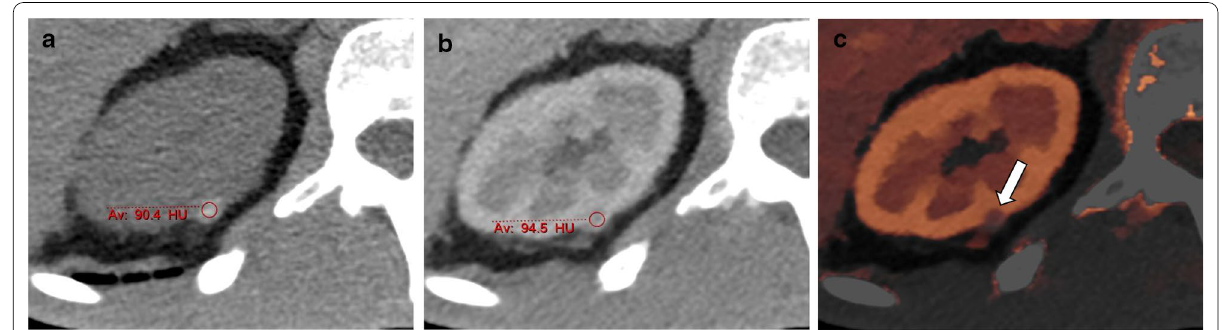
Fig. 4 An incidentally identified hyperdense right renal cyst in a 72-year-old man. Axial TNC image shows a markedly hyperdense cyst, most consistent with a hemorrhagic cyst ( a ) without enhancement on the portovenous phase image ( b ). However, iodine overlay maps show suspected mild enhancement ( c ). The iodine content of the cyst was 1.3 mg/mL, which by accepted thresholds would be considered an enhancing lesion, however, the normalized iodine content was only 0.27 mg/mL, consistent with lack of enhancement seen on conventional